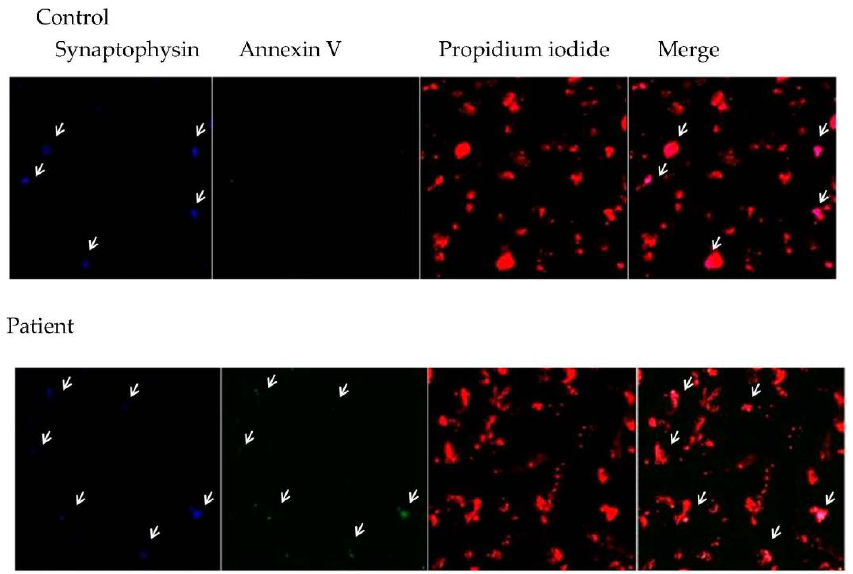
Figure 5. Confocal image of the neocortex of a control subject and a patient illustrating the immunodetection of annexin V + cells (green) doubly marked with synaptophysin (blue) and counterstained with propidium iodide (red). Note that the patient’s annexin V + cells coincide with synaptophysin + (40×).